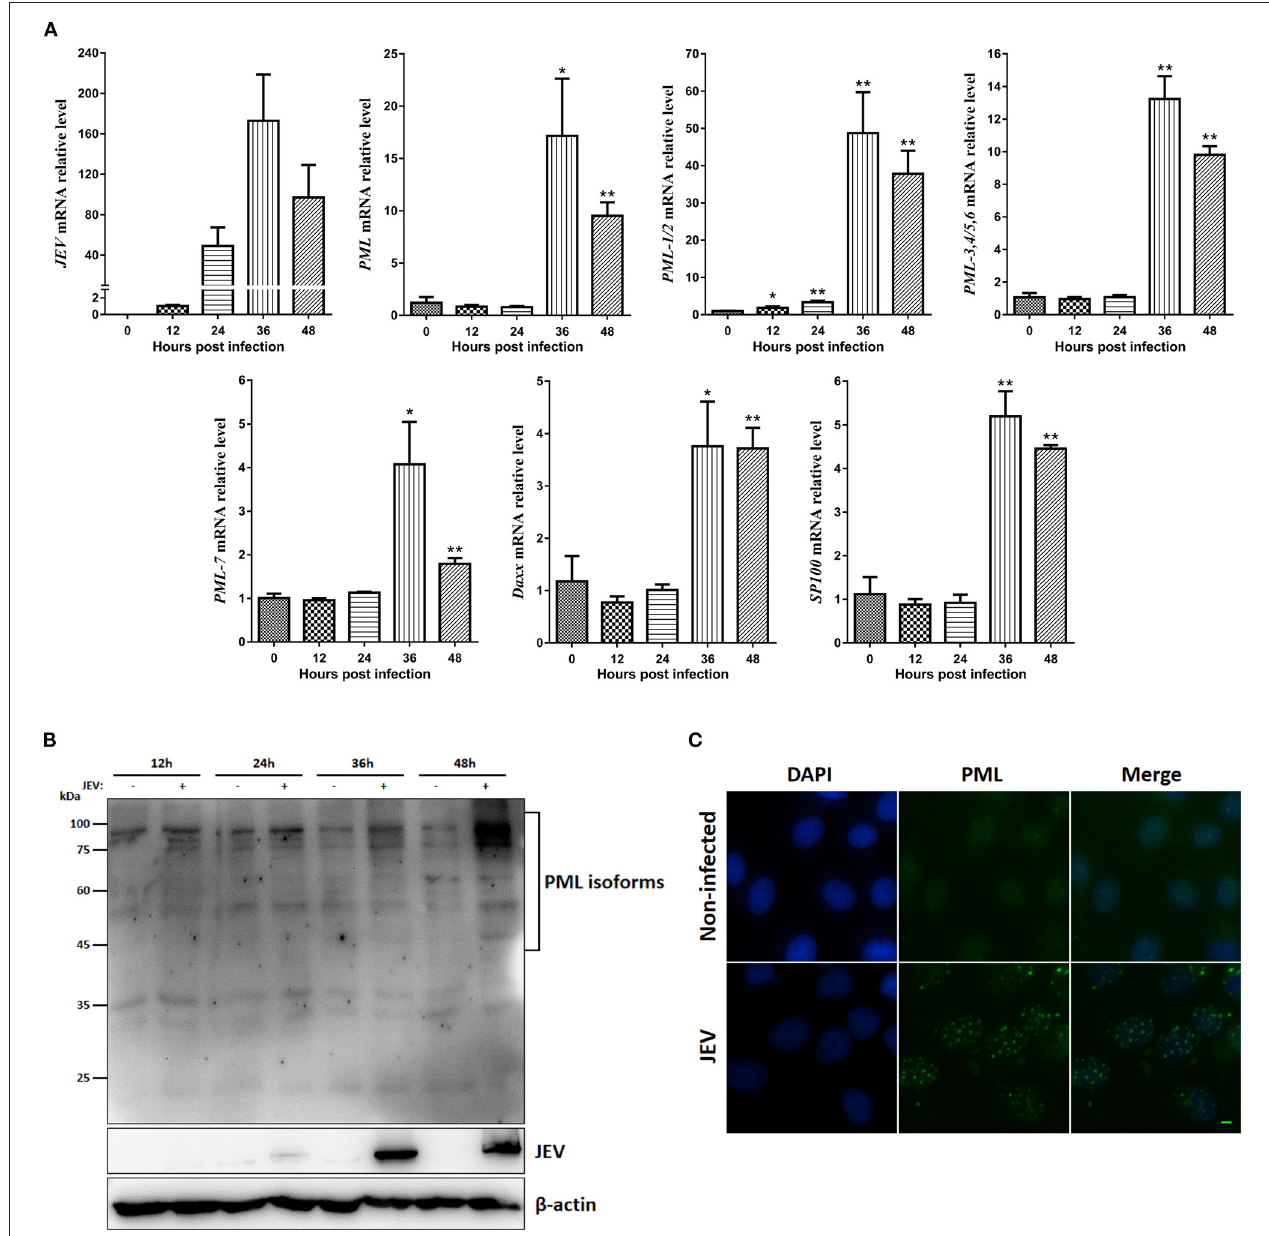
FIGURE 4 | Expression of PML isoforms, Daxx , SP100 , and PML-NBs during JEV infection. (A) JEV-E , PML isoform, Daxx , and SP100 mRNA levels were examined by RT-qPCR. GAPDH , ACTB , 18srRNA , and RPL32 levels were used as loading controls, and the relative expression levels were expressed as fold change relative to mock-infected cells. * p < 0.05, ** p < 0.01. (B) Western blotting analysis of PML protein expression during JEV infection at the indicated time points. (C) PK15 cells were infected with JEV for 36h, and then immunofluorescence staining of PML protein (green) was performed using anti-PML antibody. Nuclei were stained with DAPI (blue). Non-infected cells were used as controls. Scale bar: 10 µ